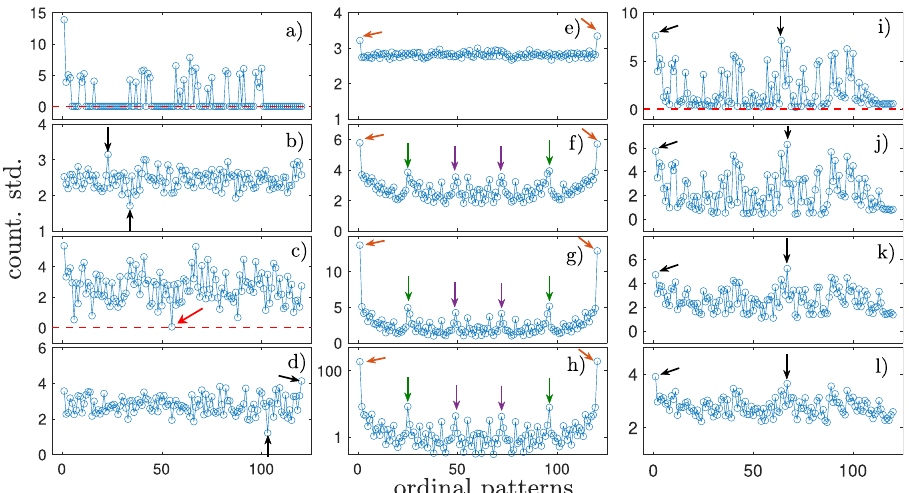
Fig. 4 Standard deviation permutation spectrum. Standard deviation of the permutation spectrum estimated from 200 windows of size l = 10 3 and for a the logistic map, b the linear congruential generator, c x and d y coordinate of the Sine map. k -noises for e k = 0, f k = 1, g k = 2 and h k = 3. i – l Noisy chaotic logistic map with additive noise with σ = 0.25, 0.5, 0.75 and 1, respectively. Red dashed line indicates zero standard deviation and arrows point out characteristic ordinal patterns. k : correlation degree and σ : intensity of the noise the local and global features of the transition matrix of all ordinal transitions, by plotting the minimum pattern entropy versus the conditional permutation entropy 69 . This representation plane places all chaotic maps below the k -noises, the latter ones locating near the diagonal — see Fig. 5b. As noise level increases, the positions of chaotic systems get closer to the linear stochastic one. This char- acterisation identi fi es the presence of forbidden patterns with null value of the minimum pattern entropy, as the case of logistic map.